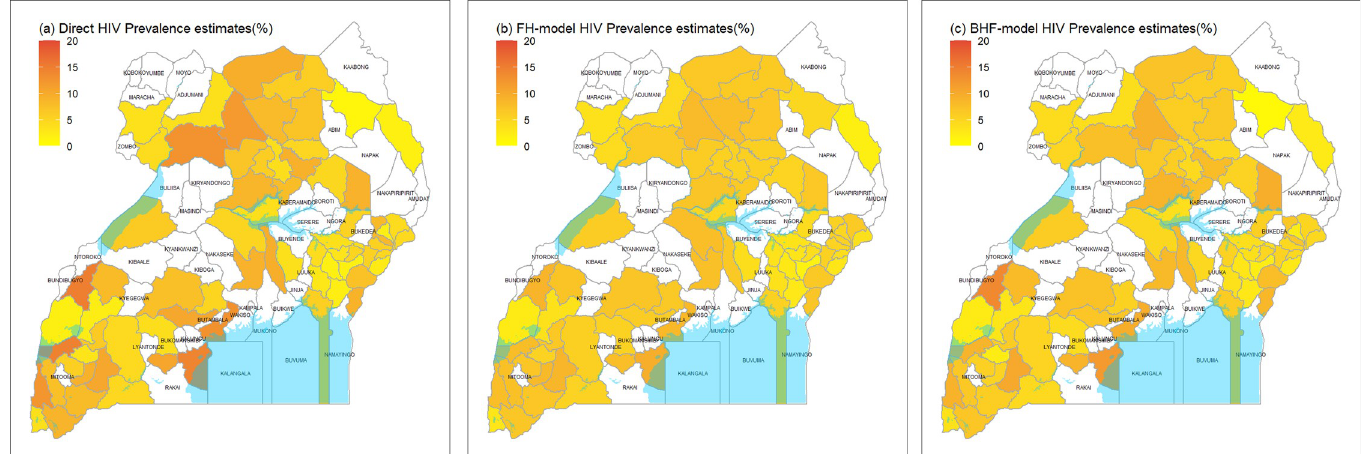
Fig 1. Comparison of HIV prevalence estimates in Uganda. Fig 1 presents district-level prevalence estimates: (a) Direct survey estimates, (b) area-level model estimates, and (c) unit-level model estimates. Scales for each of the maps were maintained to show the extent of extreme values. Unshaded areas represent district that did not complete LQAS surveys in